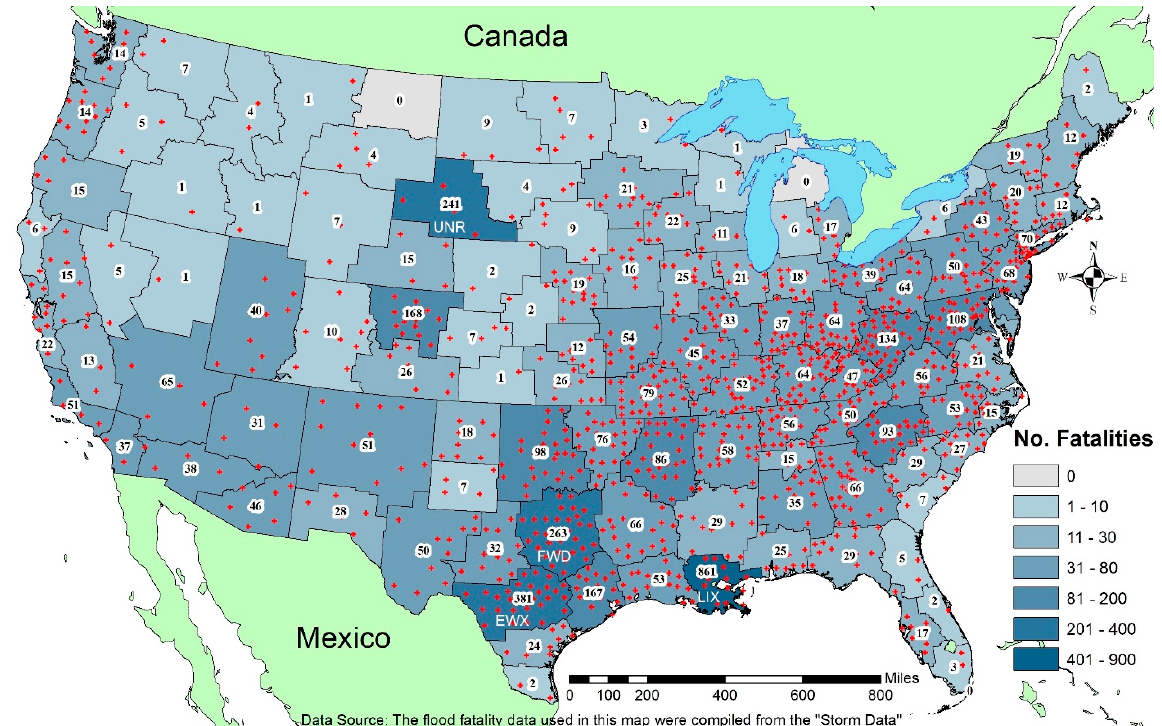
Figure 2. Flood fatalities by NWS WFO service area. The dots represent counties where fatalities were reported (many counties reported more than one fatality).